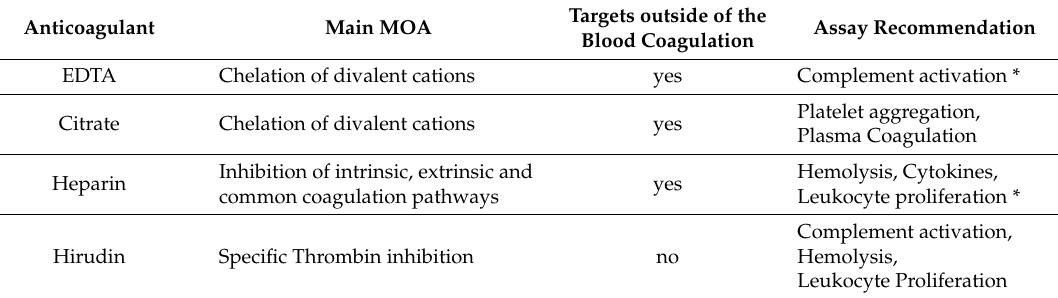
Table 2. Recommendation for anticoagulant use in in vitro assays for nanoparticle characterization. Each anticoagulant has its own mechanism of action. The type of anticoagulant may influence assay performance. Each anticoagulant in this table matches the assay for which it provided the optimal assay performance. Assays noted with a * mean that while this anticoagulant is not ideal for the given assay, it can be used in the situations where hirudin is not available. It should also be noted that EDTA is commonly used in clinic if the blood analysis requires an estimation of the platelets count. MOA: mechanism of